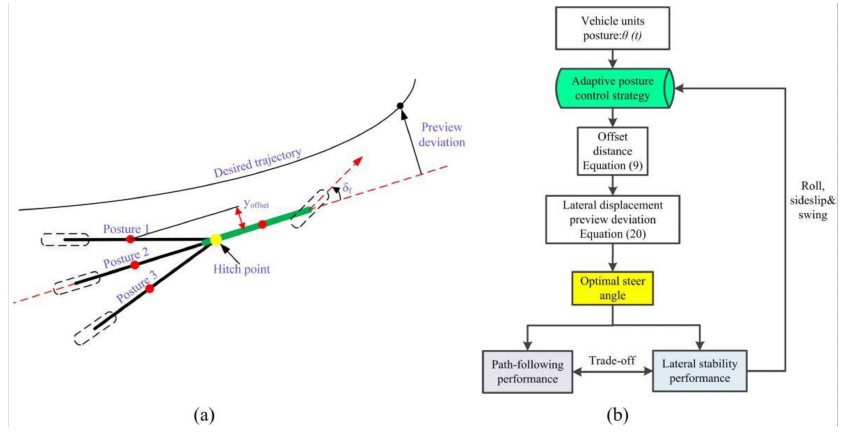
Figure 5. Principle of posture control. ( a ) Three postures. ( b ) Posture control flow. As shown in Figure 5b, the function of the posture control strategy is to adjust the offset distance in response to changes in articulation angle, roll, sideslip and swing of the body units to obtain the optimal steer angle. Let us define the preview point on the left side of the longitudinal axis of the tractor and the articulation angle rotating clockwise relative to the tractor as positive and the right as negative. Table 2 shows the effect of the sign of k offset on the preview deviation under three postures. “+” indicates an increase, and “ − ” indicates a decrease. The above rules also apply to the situation where the preview point is on the right side of the longitudinal axis of the tractor. Table 2. Effect of k offset on the preview